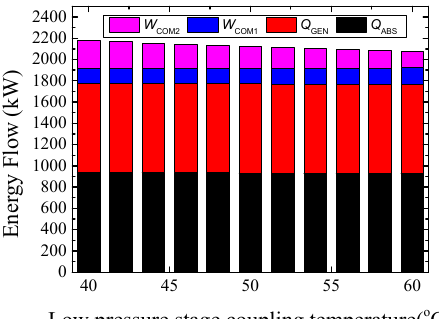
Figure 7. Effect of low pressure stage coupling temperature on coupling cycle COP.